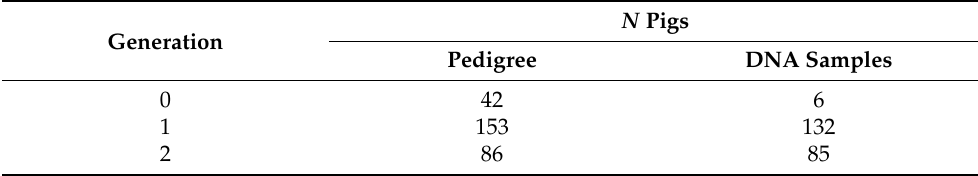
Table 4. Number of Nero Lucano pig DNA samples analyzed with Illumina PorcineSNP60 BeadChip within each generation. N Pigs Generation Pedigree DNA Samples 0 42 6 153